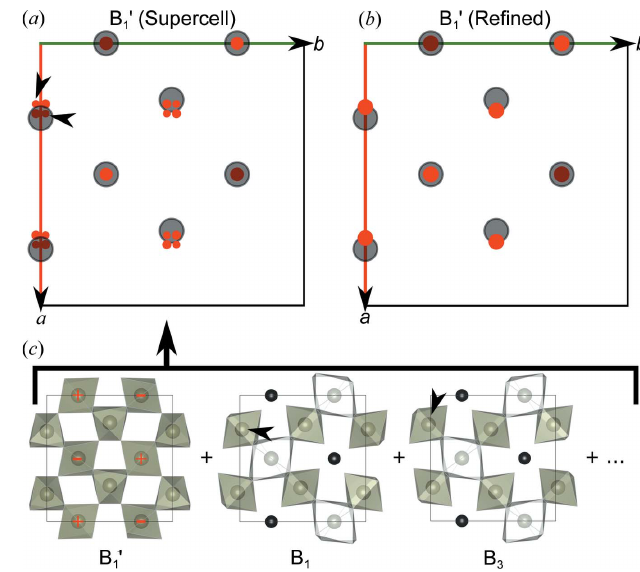
Figure 5 Comparison of the B 0 layers of ( a ) the condensed supercell and ( b ) the 1 structure refined against Bragg diffraction (oxide ions have been omitted and 24 d cation sites are shown in semitransparent grey). The red markers in the B 0 layer of the refined structure indicate the refined positions of the 1 new metal ion site near the 24 d site. The red markers in the B 0 layer of the 1 condensed supercell indicate positions of additional electron density contributed by the cations of the braunite intergrowths. ( c ) Illustrates how the B 0 layer of the condensed supercell is obtained by averaging 1 contributions from the bixbyite host crystal and the braunite inter- growths. In the B 0 layer in ( c ), red + symbols indicate cations that are 1 displaced out of the z = 0.25 plane, and – symbols indicate cations displaced to lower z values. In the B i layers in ( c ), black arrowheads mark examples of cations which contribute to the electron density residuals marked by black arrowheads in the B 0 layer of the condensed supercell in 1 ( a